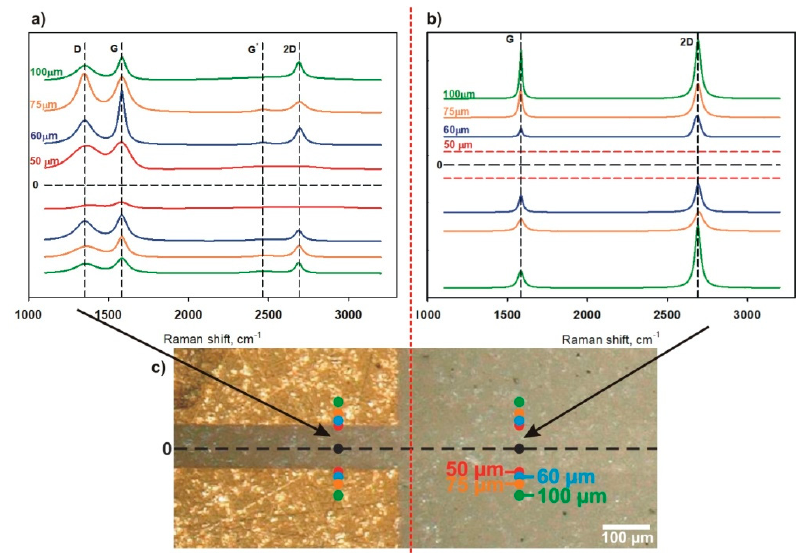
Figure 6. Raman spectra of high strength metallurgical graphene (HSMG ® ) after laser machining: ( a ) Raman spectrum of laser irradiated graphene on a Au / Al 2 O 3 substrate, ( b ) the Raman spectrum of laser-irradiated graphene on Al 2 O 3 , and ( c ) sample marked with points of acquisition of the Raman spectra.